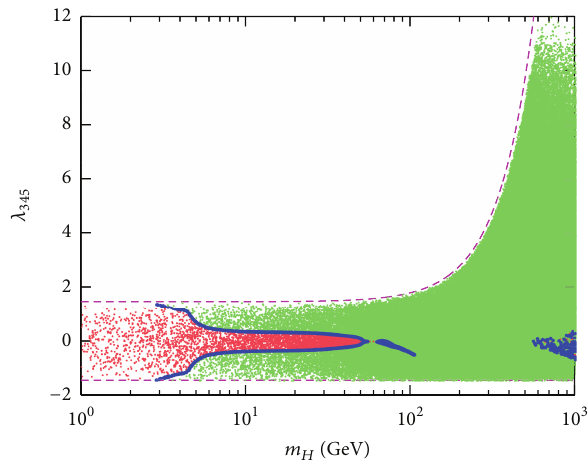
Figure 1: Random scan of IHDM parameter space. Coupling 𝜆 345 as a function of the DM candidate mass 𝑚 𝐻 . The upper dotted line is the bound generated by the inert vacuum condition and the lower dotted line is generated by the vacuum stability